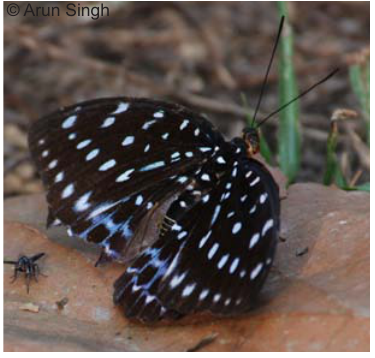
Image 47a. Dark Archduke Lexias dirtea khasiana (female)